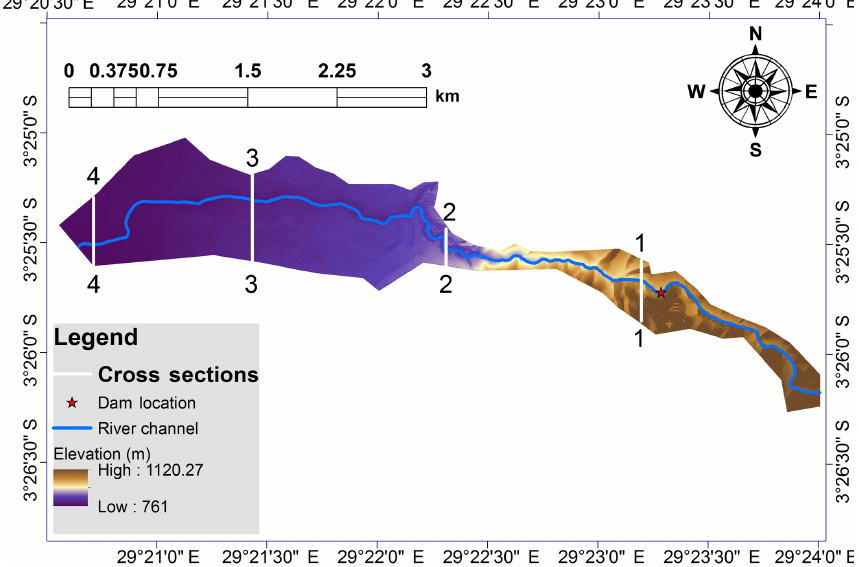
Figure 3. Digital elevation model (m) used for hydraulic modelling within the computational domain, with cross sections where hydrographs were extracted and dam location. The river main channel is also highlighted.